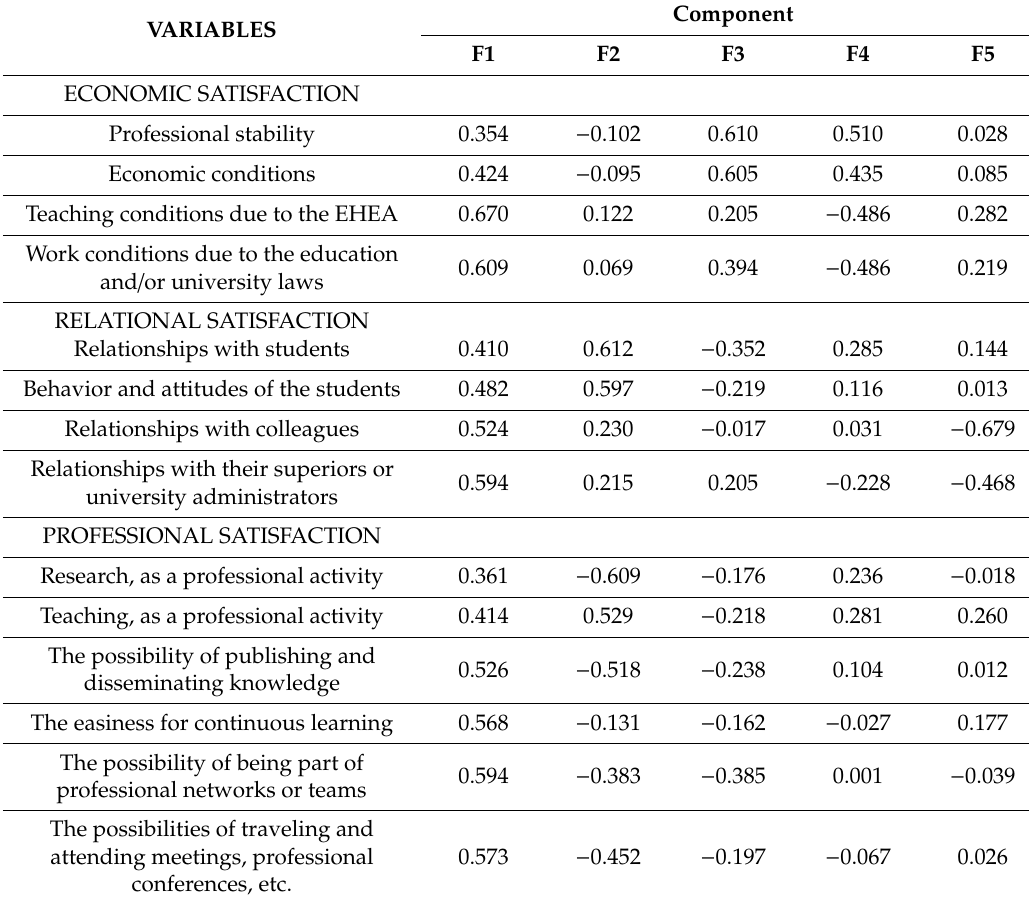
Table 2. Component matrix of the